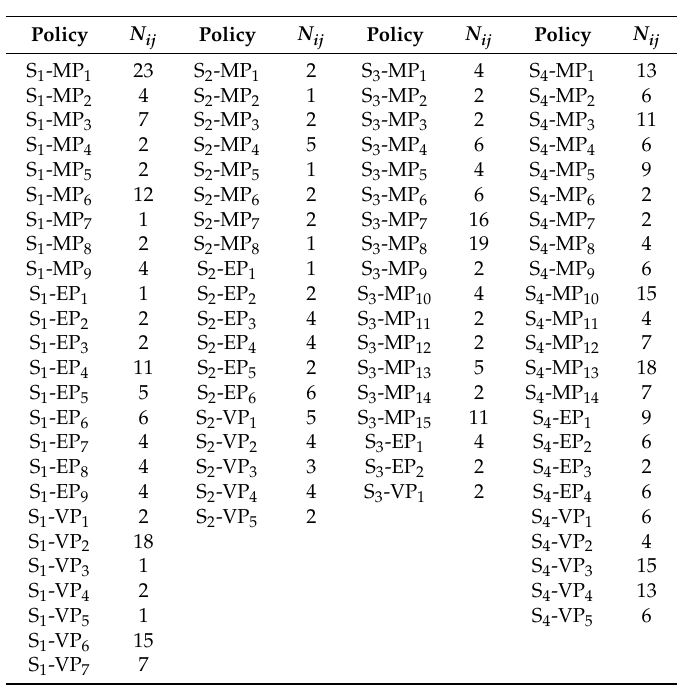
Table 11. Number of cities in applying emission reduction policies.